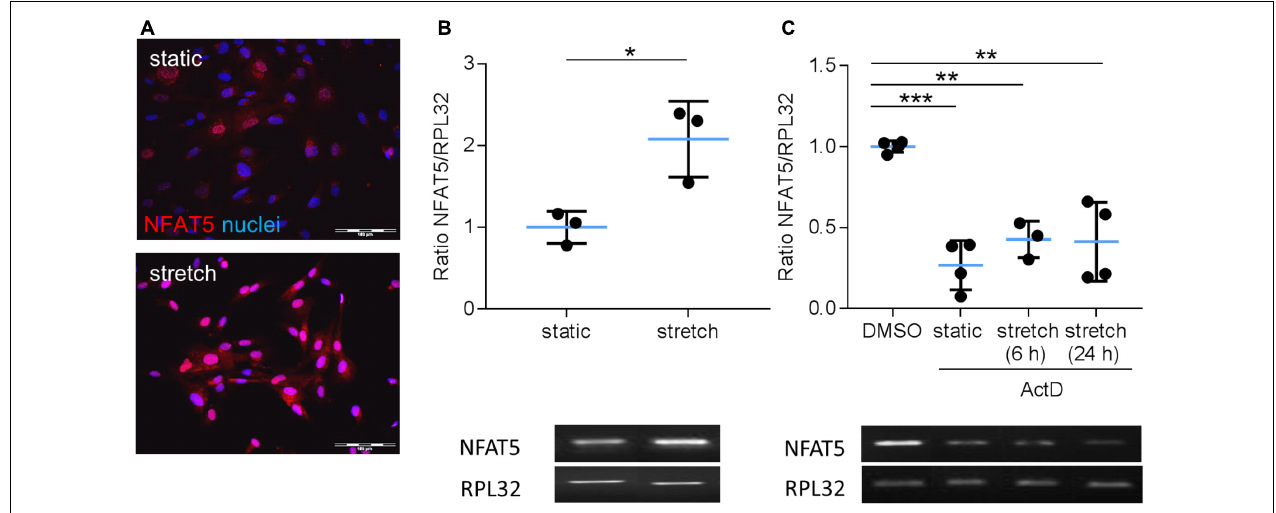
FIGURE 1 | Analysis of NFAT5 mRNA expression in VSMCs. Localization of NFAT5 protein was detected by immunofluorescence ( A , scale bar: 100 µ m) and NFAT5 mRNA expression was analyzed by semi-quantitative PCR ( B , ∗ p < 0.05, n = 3, unpaired, 2-tailed Student’s t -test; the expression of the housekeeping gene RPL32 served as internal standard) in resting and stretch-stimulated (24 h) cultured HUASMCs. After treatment (24 h) with actinomycin-D NFAT5 mRNA expression declined ( C , ActD; ∗∗∗ p < 0.001, ∗∗ p < 0.01, n = 4; one-way ANOVA and Tukey post-test).